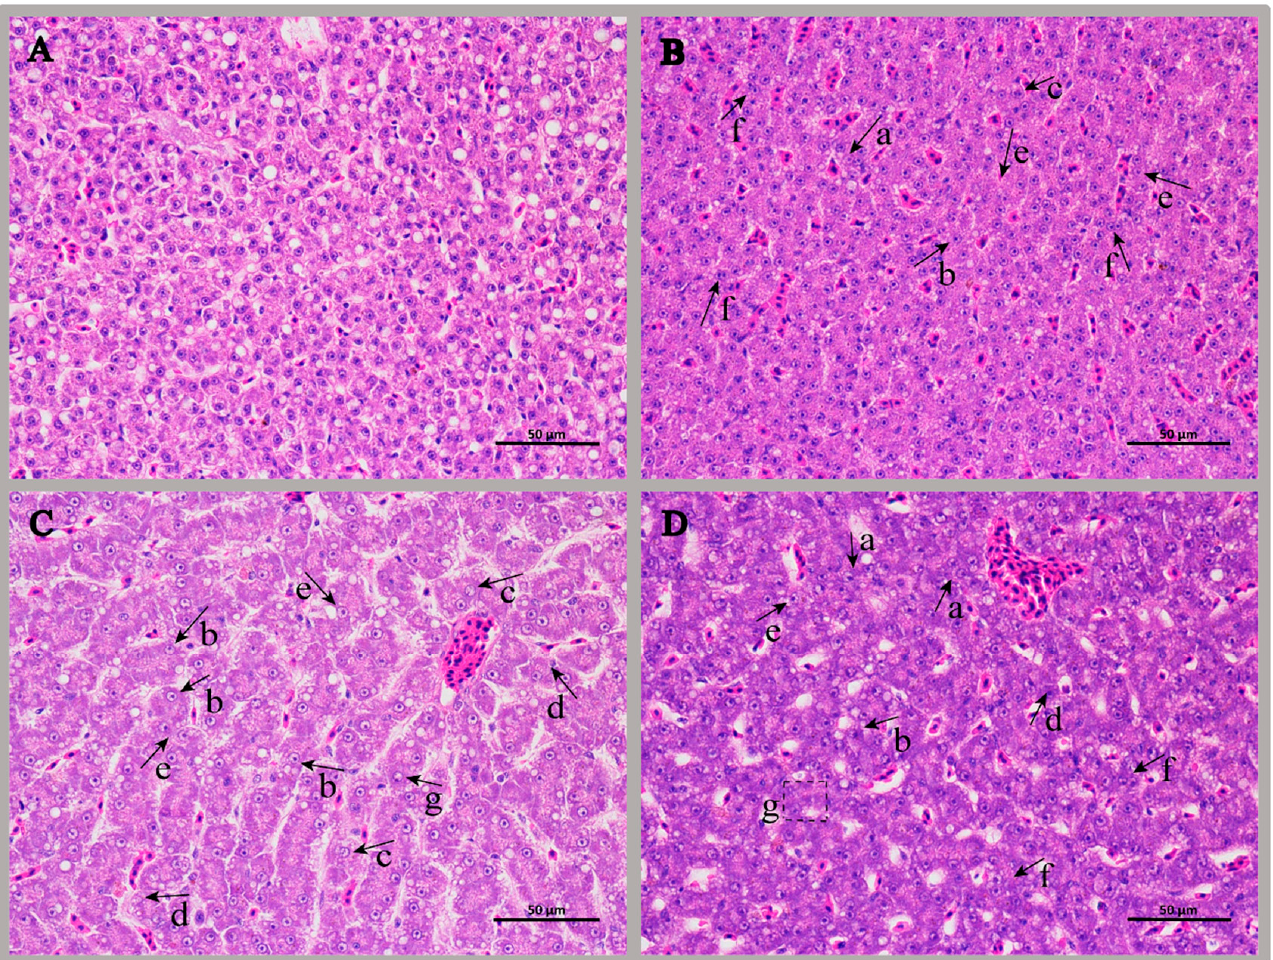
Figure 1. Histopathological examination of the livers of golden pompano infected with S. agalactiae . Notes: ( A ) represents a normal liver tissue section, HE, bar = 50 µ m; ( B – D ) Representative liver tissue sections from three fish at 120 h of infection, respectively, HE, bar = 50 µ m. a, liver sample in which liver cell boundaries were not well defined; b, liver sample with enlarged and severely displaced cells; c, liver sample exhibiting hepatic cytoplasmic lysis; d, liver sample exhibiting amyloidosis in the cells surrounding the hepatic sinusoids and cloudy eosinophilic staining of the cytoplasm; e–f, liver sample in which the cell membrane was disintegrated and the cells joined together, creating the illusion of binucleation; g, liver sample exhibiting multifocal necrosis.